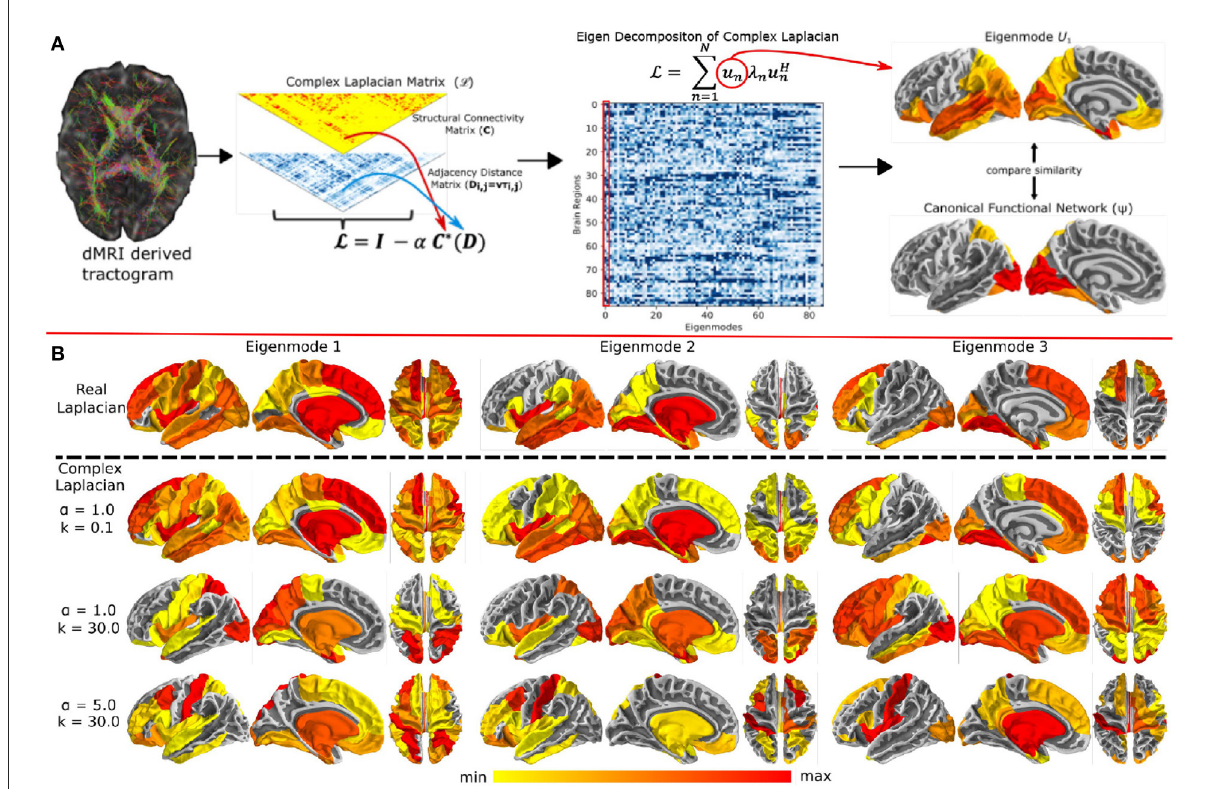
FIGURE1 (A) Overview of the complex Laplacian eigenmode decomposition. The complex Laplacian matrix L is computed from the structural connectivity matrix ( C ) and distance adjacency matrix ( D ) which were extracted from diffusion MRI. Then, eigendecomposition of the Laplacian L provided the complex structural eigenmodes. The spatial similarities between these eigenmodes and the canonical functional networks in fMRI was done for model parameter tuning. (B) Complex Laplacian eigenmodes for different coupling strength and wave number. Top row: eigenmodes from the real Laplacian matrix with coupling strength = 1. Bottom three rows: Complex Laplacian eigenmodes for small wave number (top), high wave number (middle), and high wave number and coupling strength (bottom). Figure is extracted from Xie et al.